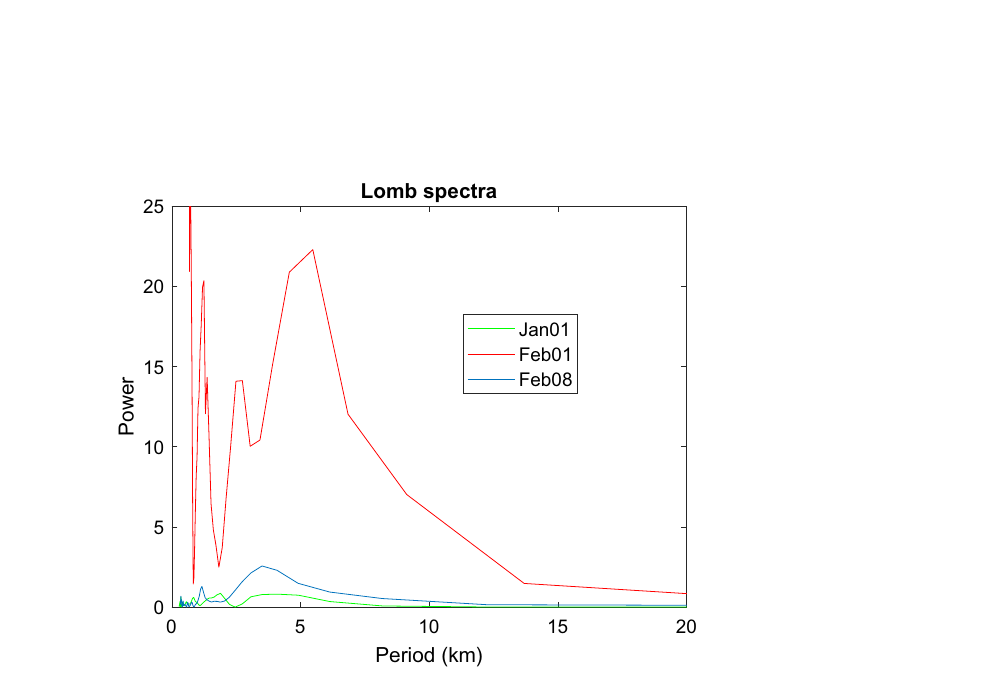
Figure 7. Power spectrum of the Lomb-Scargle analyses for temperature anomaly of Fig.